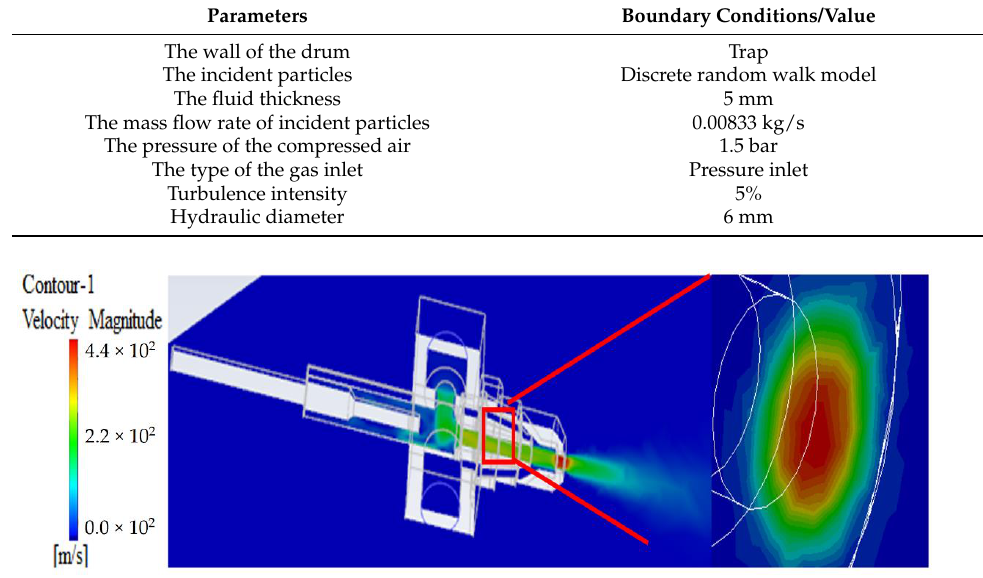
Table 1. The parameters and conditions used in the simulation.